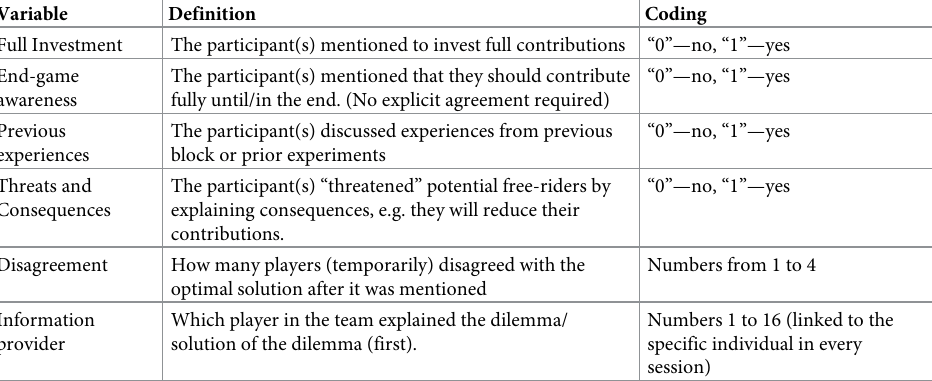
Table 6. Definition of the coded